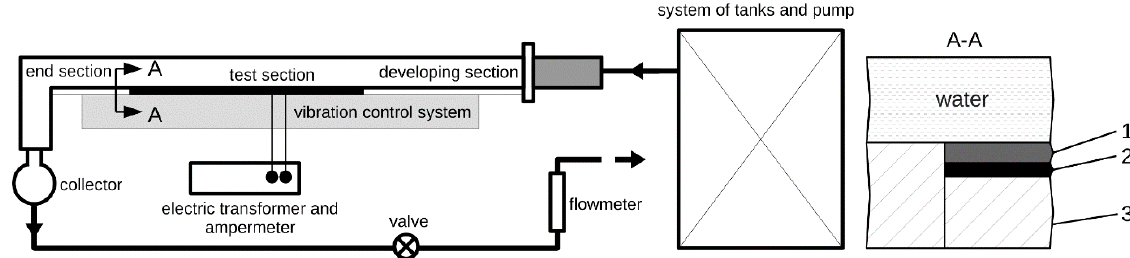
Fig. 3. Scheme of water circuit by Benderradji et al. 1 copper shee t , 2 heater, 3 transparent polycarbonate.